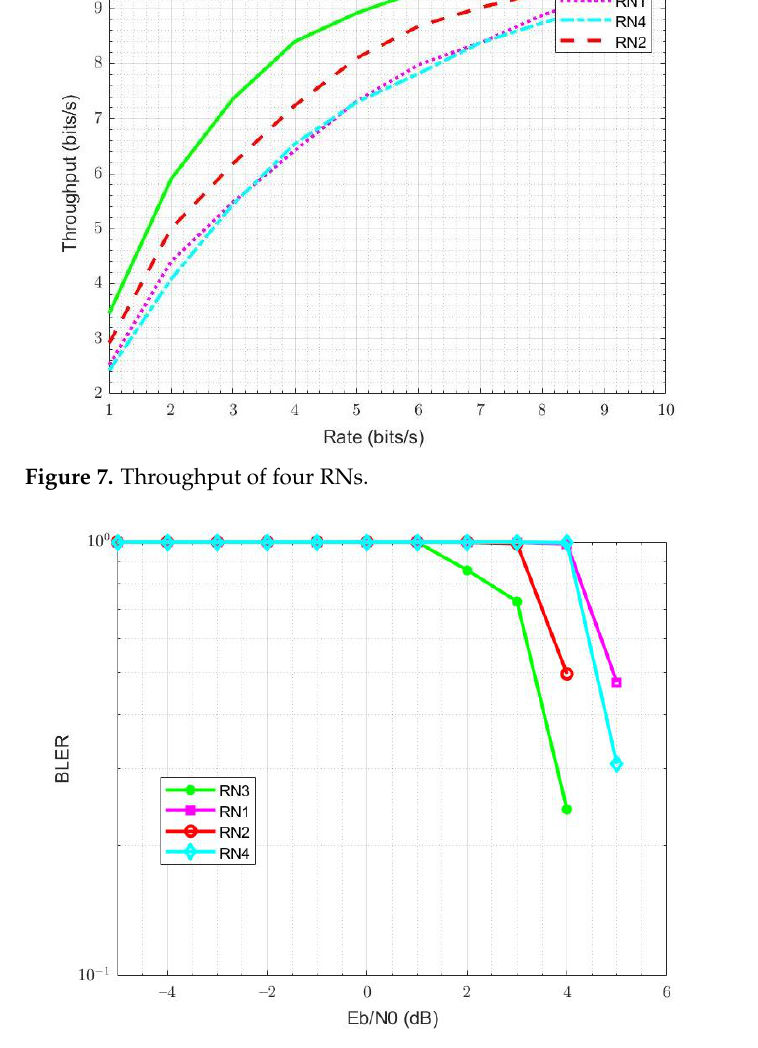
Figure 8. BLER of four